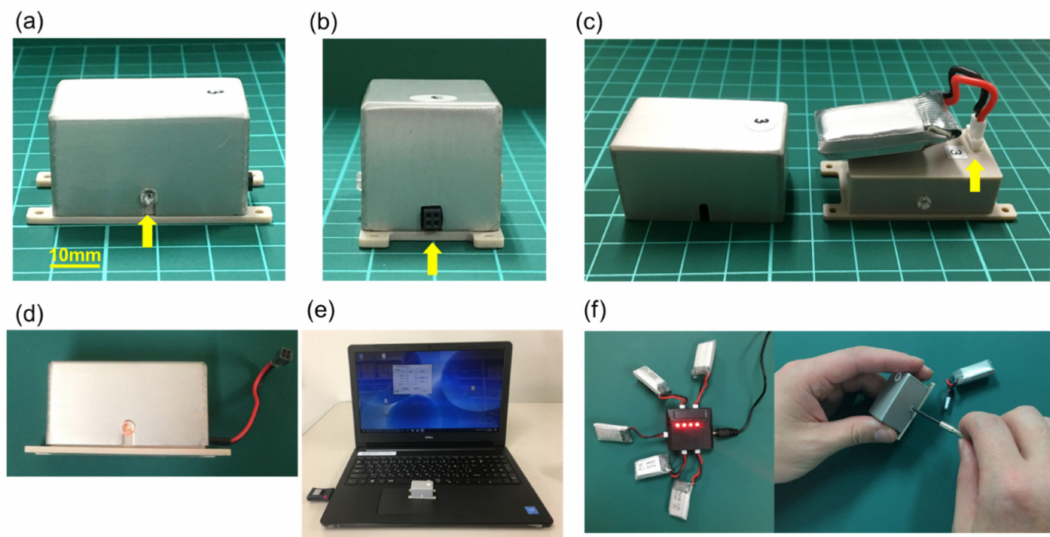
Figure 1. Newly developed stimulating system. ( a ) The lateral side of the SAS-200. A yellow arrow shows the transparent screw in which the LED light is attached to the electronic circuit board to confirm the energization. ( b ) The frontal side of the SAS-200. A yellow arrow is showing the external terminal of the SAS-200 where the stimulation electrode is connected. The external terminal can be extended with a lead type connection. ( c ) The lithium-ion battery in the aluminum chassis. The lithium-ion battery is connected to the control board inside the plastic chassis (arrow). ( d ) Flickering of the LED light located inside of SAS-200 through the transparent screw can indicate the stimulation command input and battery residual. The extensional lead can be attached to SAS-200. ( e ) SAS-200, Windows PC, and Bluetooth dongle for SAS-200. The recent Windows PC adapted with SAS-200 and its dongle. ( f ) Charging lithium-ion battery via USB cable. The battery can be exchanged by loosening two screws on the lateral side of SAS-200.